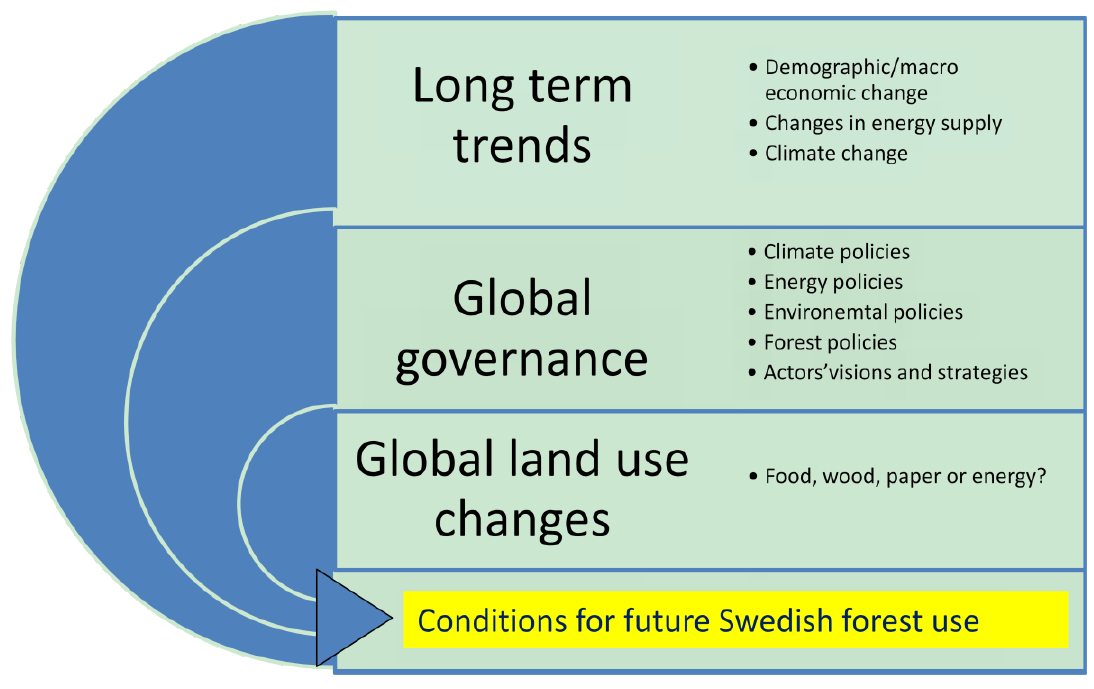
Figure 1. Global trends and future Swedish forest